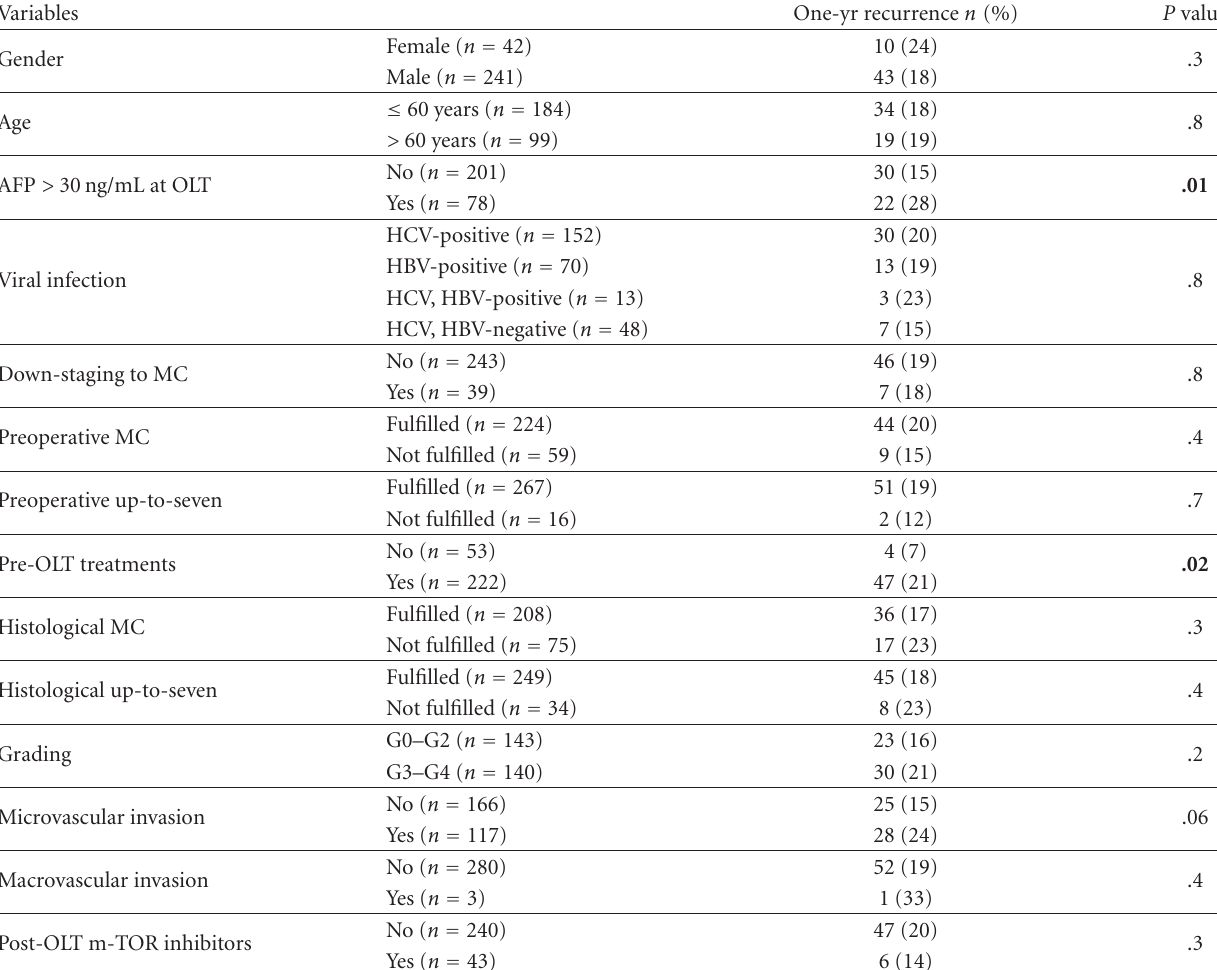
Table 4: Analysis of factors a ff ecting one-year tumor recurrence rate in patients with